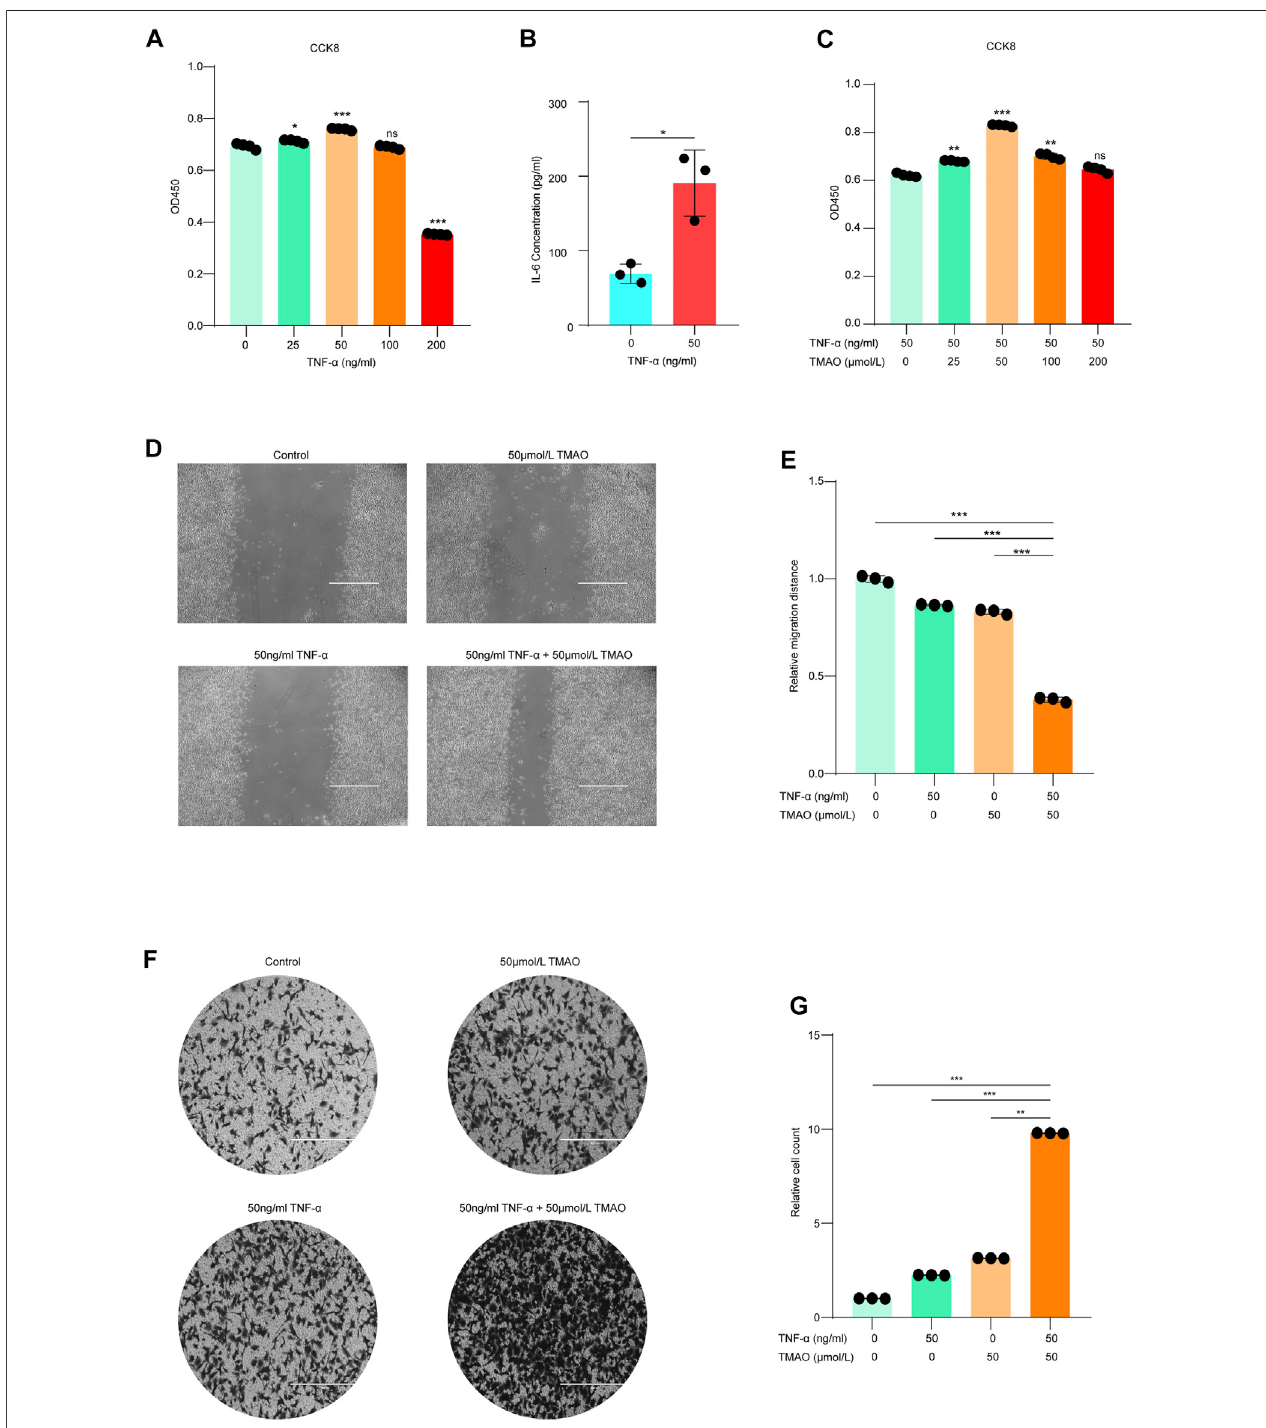
FIGURE 1 | TMAO synergistically enhances the tumorigenicity of Hepa1-6 cells in the presence of TNF- α . (A) TNF- α dose-dependently promoted the proliferation of Hepa1-6 cells; maximum proliferation was observed at 50 ng/ml TNF- α ; results are mean ± SD ( n = 3 per group); one-way ANOVA with Bonferroni ’ s test; ***, p < 0.001. (B) Hepa1-6 cells treated with 50 ng/ml TNF- α expressed higher levels of IL-6 compared to untreated cells; results are mean ± SD ( n = 3 per group); Student ’ s t-test; ***, p < 0.001. (C) The combination of 50 ng/ml TNF- α and 50 μ M TMAO led to the maximal synergistic increase in cell proliferation; results are mean ± SD ( n = 3 per group); one-way ANOVA with Bonferroni ’ s test; ***, p < 0.001. (D,E) Wound healing assay con fi rmed that 50 ng/ml TNF- α alone and 50 μ M TMAO alone slightly promoted the migration of Hepa1-6 cells compared to untreated control cells, while the combination of 50 ng/ml TNF- α and 50 μ M TMAO synergistically and